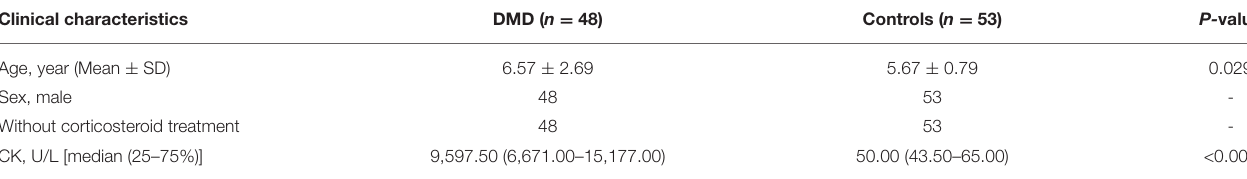
TABLE 1 | Characteristics of the DMD patients and controls in this study. Clinical